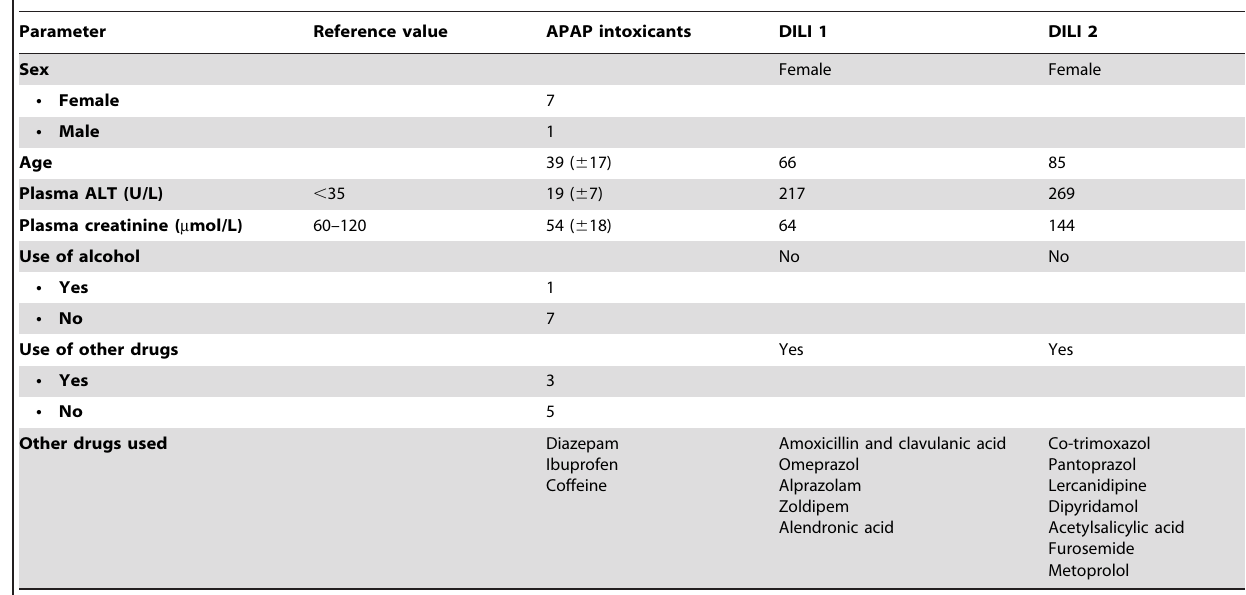
Table 1. Demographics acute DILI